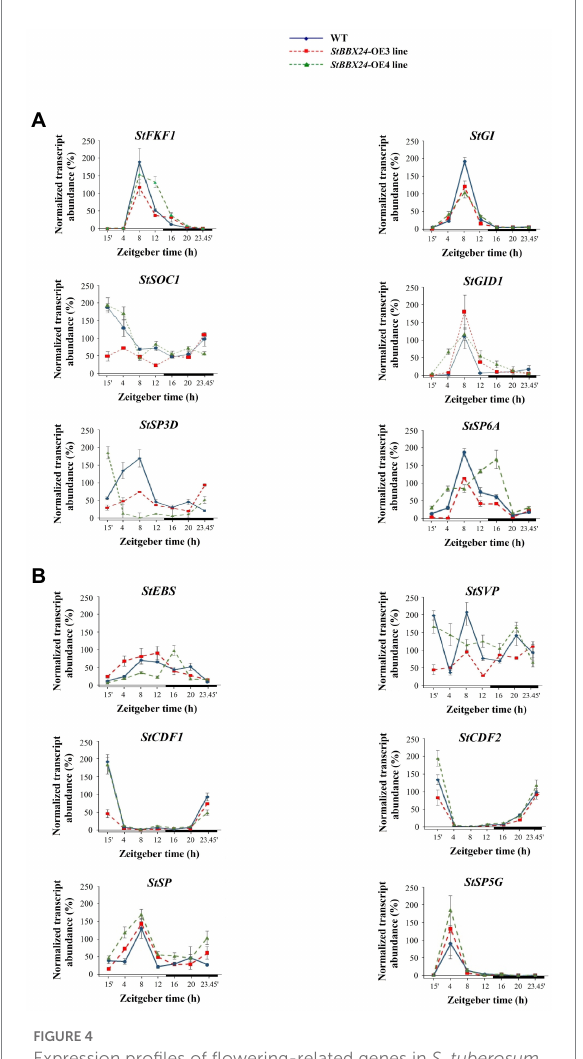
FIGURE 3 Expression profiles of flowering-related genes in S. tuberosum plants silenced for StBBX24 expression. Quantitative RT-PCR analysis of StFKF1 (ID: PGSC0003DMG400019971), StGI (ID: PGSC0003DMG400018791), StSOC1 (ID: PGSC0003DMG401024252), StGID1 (ID: PGSC0003DMG400000139), StSP3D (ID: PGSC0003DMG400016179), StSP6A (ID: PGSC0003DMG400023365) (A) and StEBS , StSVP (ID: PGSC0003DMG400016203), StCDF1 (ID: PGSC0003DMT400047370), StCDF2 (ID: PGSC0003DMT400003359), StSP (ID: PGSC0003DMG400007111), StSP5G (ID: PGSC0003DMG400023365) (B) transcript levels in leaves of WT, amiRBBX24.1.13 and amiRBBX24.1.17 3-week old